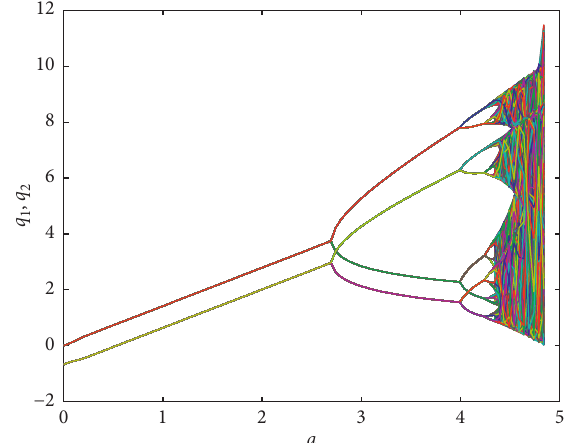
Figure 6: The bifurcation diagram and MLEs for game (12) with respect to control parameter k at a � 6 , b � 0 . 3 , c β � 0 . 2.